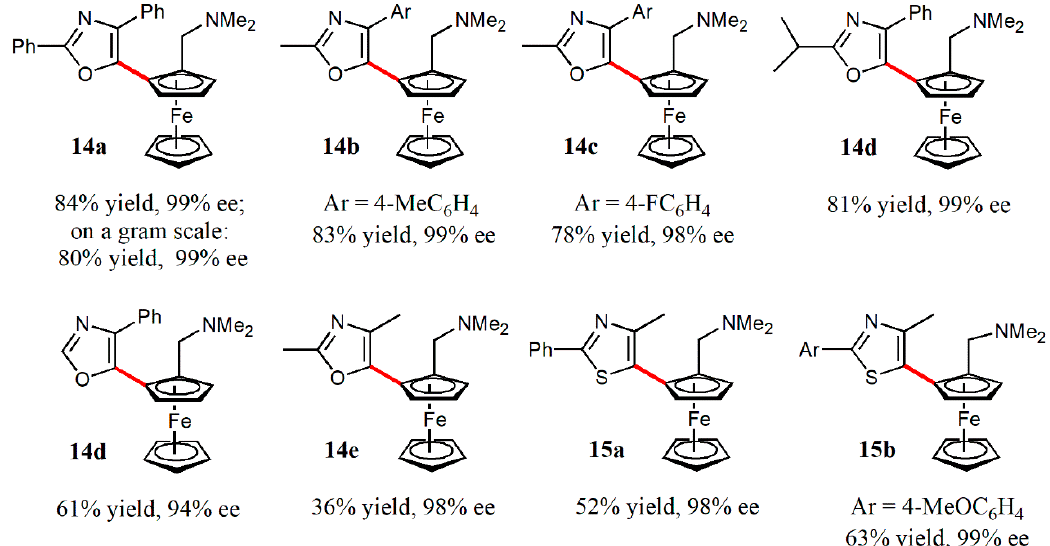
Figure 6. Enantioselective CDC between ferrocenes and azoles.